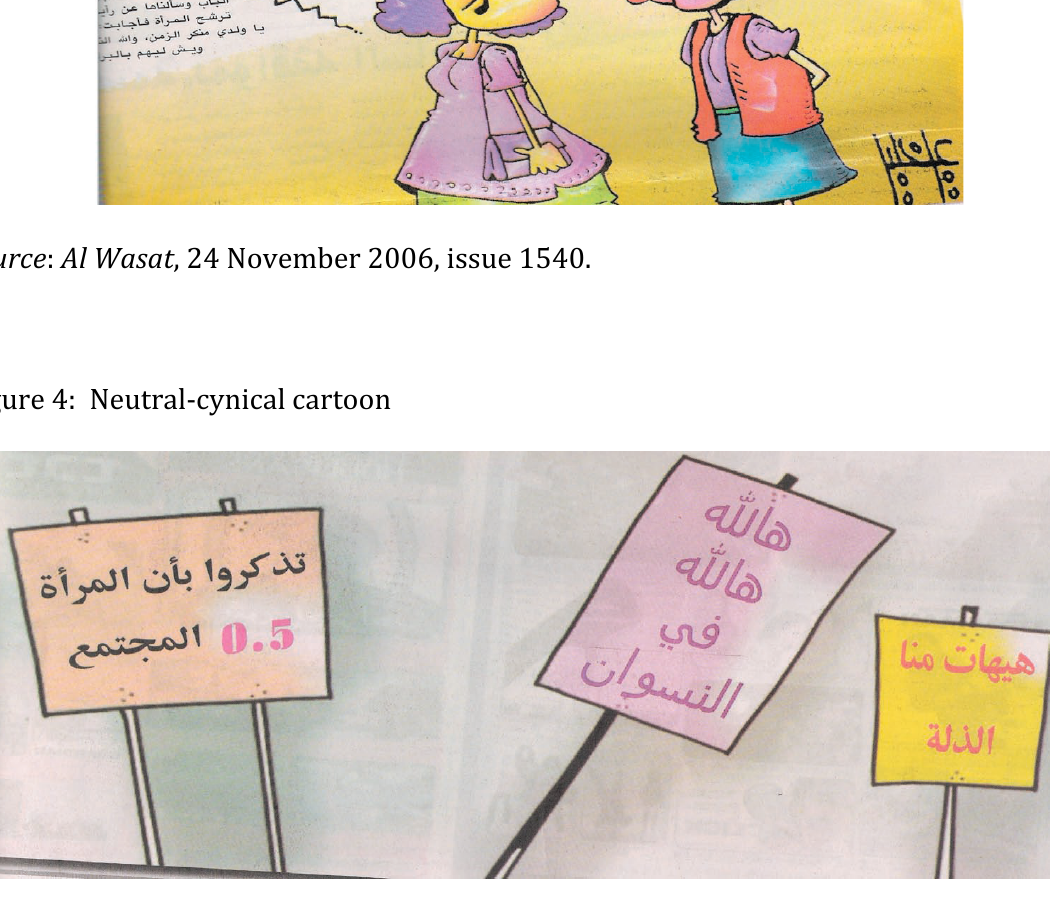
Source : Al Wasat , 13 November 2006, issue